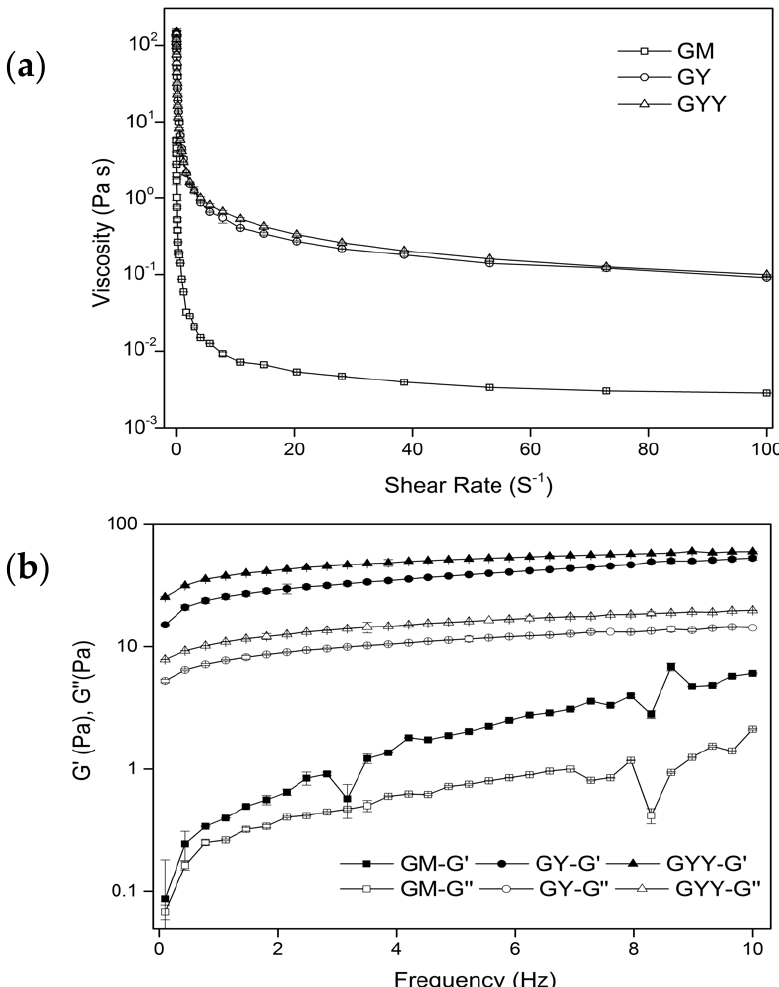
Figure 3. ( a ) Apparent viscosity as a function of shear rate for GM, GY, and GYY; ( b ) frequency sweeps of GM, GY, and GYY with storage modulus (G’) and loss modulus (G”).